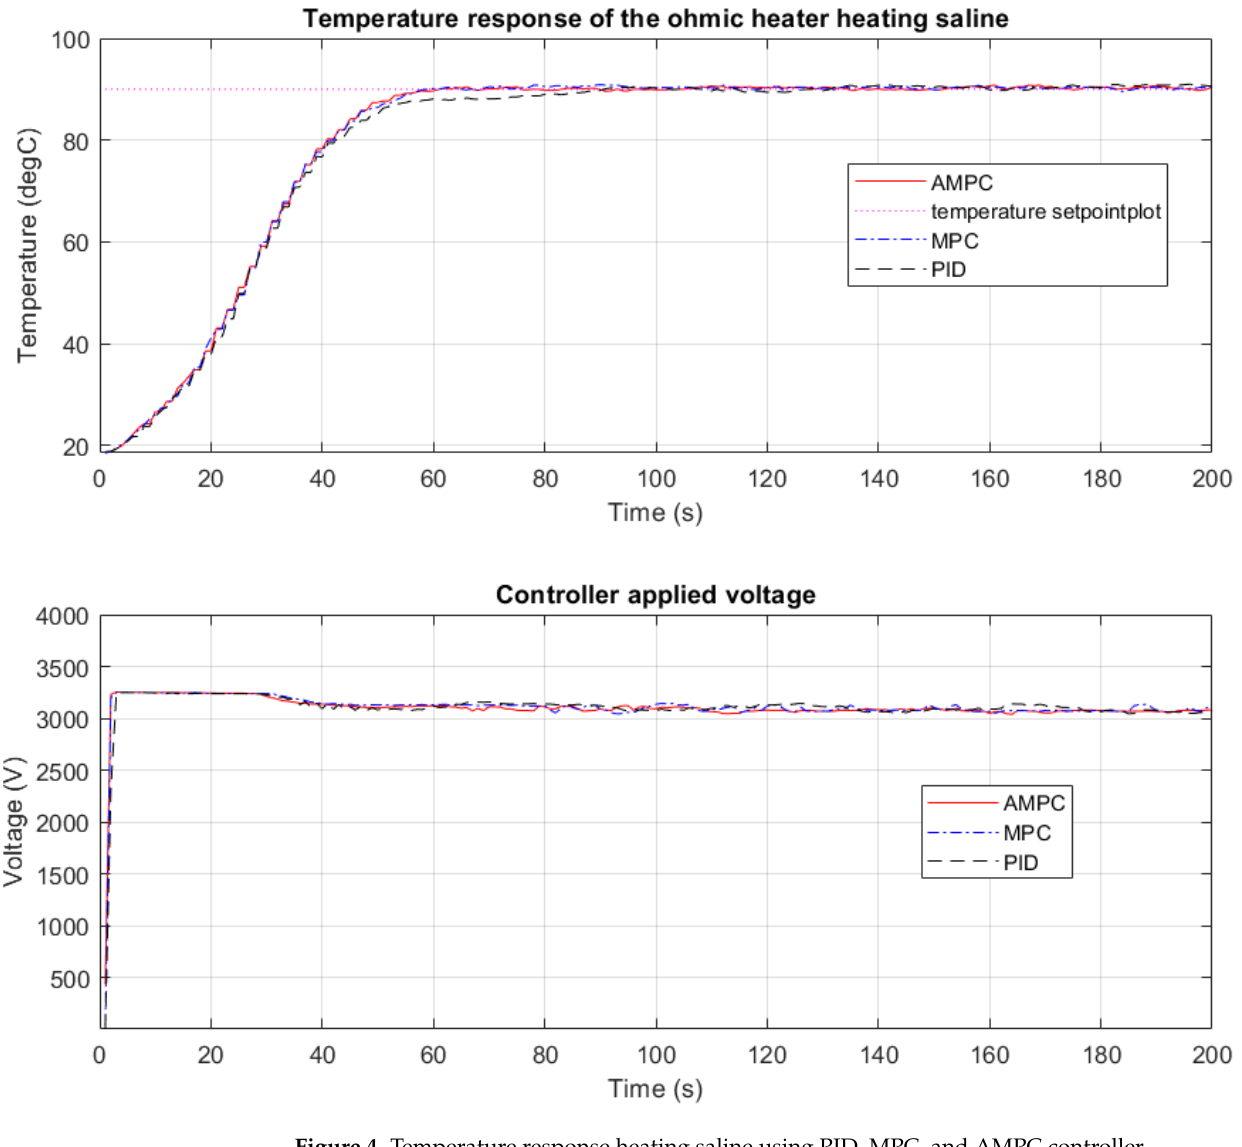
Figure 4. Temperature response heating saline using PID, MPC, and AMPC controller.